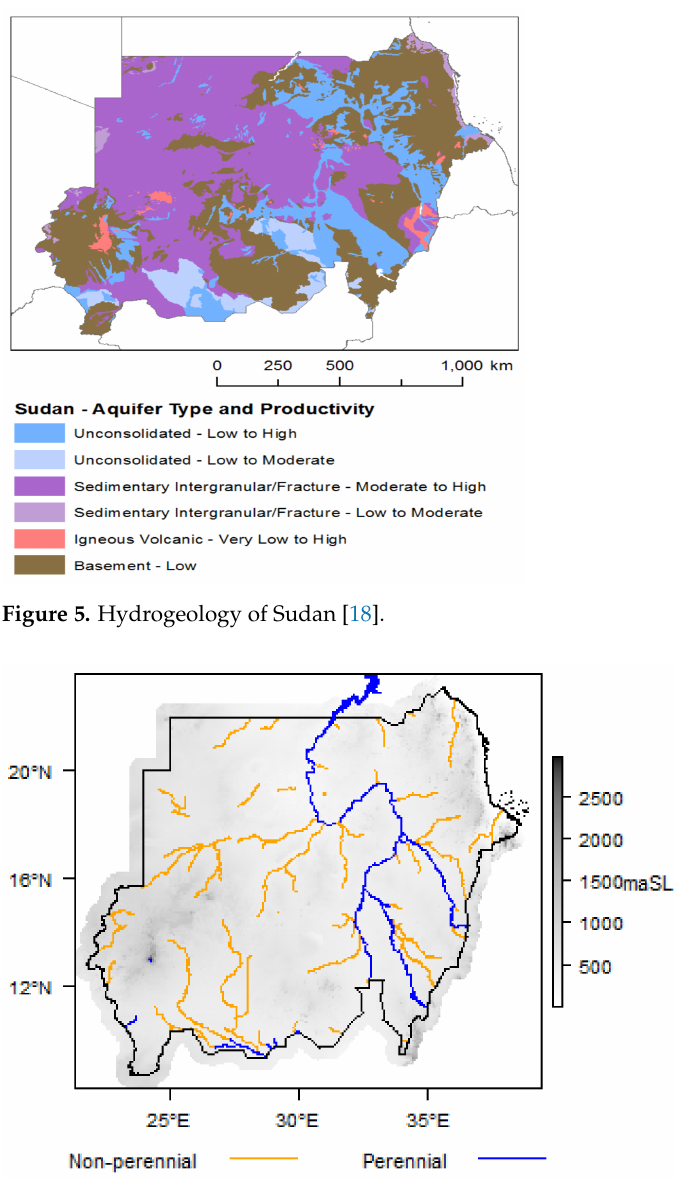
Figure 6. Major surface water features in Sudan